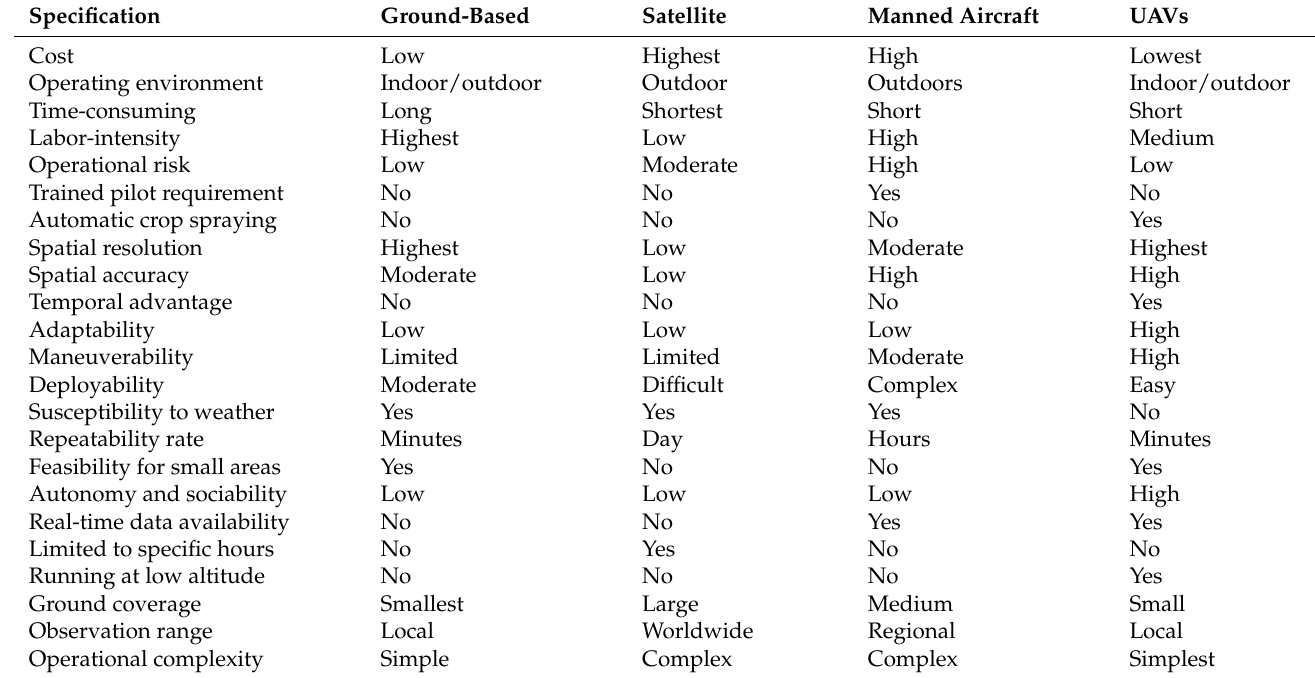
Table 2. Technical comparison of common RG platforms used in precision